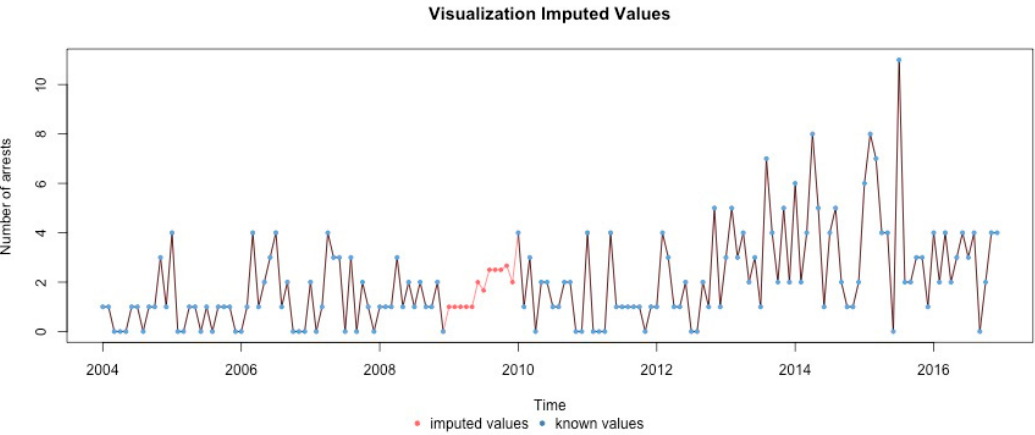
FigureA5. Methamphetamineneighboringcountriesarrests2004–2016intheCzechRepublic—imputed Figure A5. Methamphetamine neighboring countries arrests 2004–2016 in the Czech Republic – missing imputed missing values.